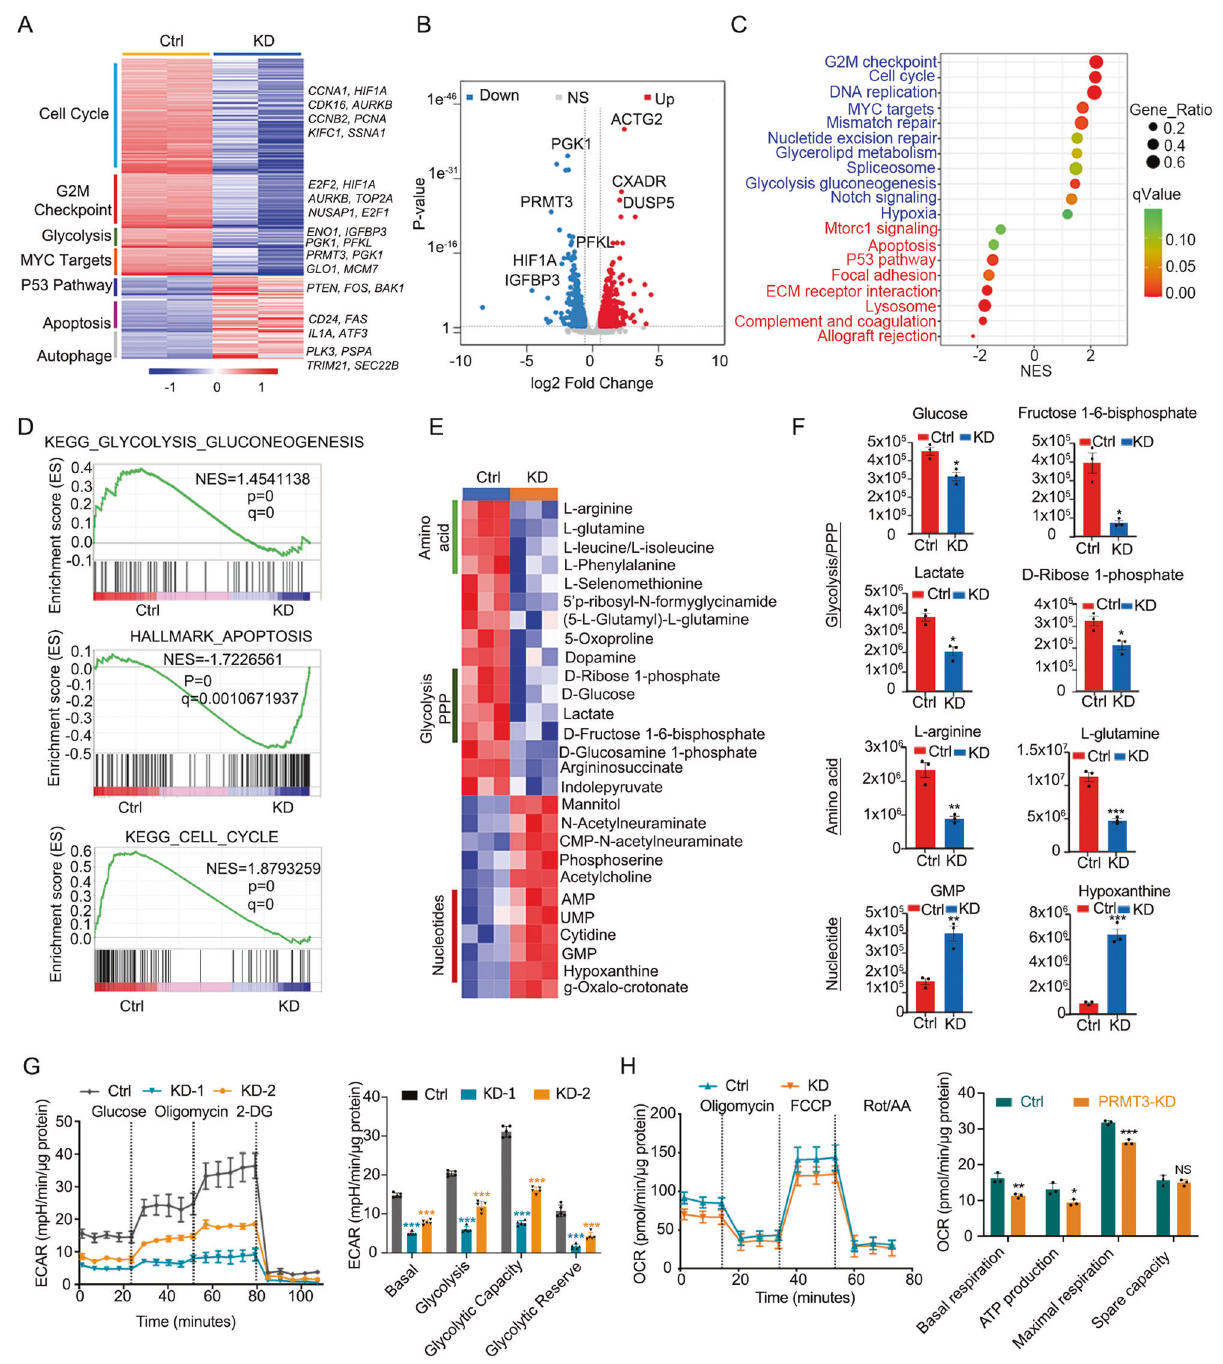
Fig. 6 PRMT3 de fi ciency decreases GBM progression by inhibiting aerobic glycolysis. A Heatmap of the genes differentially expressed in control and PRMT3-KD U251cells after 72 hr. B Volcano plot of transcriptome pro fi les of wild-type and PRMT3-KD U251cells. Red and blue dots represent genes signi fi cantly upregulated or downregulated, respectively in PRMT3-KD cells compared to wild-type cells (fold change >1.5, p < 0.05). C KEGG analysis of the upregulated and downregulated genes in PRMT3-KD compared with wild-type U251cells. D GSEA enrichment plots of the glycolysis pathway, apoptosis and cell cycle pathway showing the comparison of gene expression pro fi les in wild-type U251cells and PRMT3-KD cells. NES, normalized enrichment score; p value, represents the statistical signi fi cance of the enrichment score. E Heatmap of the metabolites changed in PRMT3-KD GSC20 cells. F Relative levels of the metabolites in glycolysis/PPP, amino acid and nucleotide metabolism in Ctrl (red) and PRMT3-KD (blue) GSC20 cells. Data are presented as means ± SEM; n = 3 independent experiments; * p < 0.05; ** p < 0.01; *** p < 0.001; two-tailed unpaired Student t-test. G ECAR was measured with a Seahorse XF96 Flux analyzer (left) and quanti fi cation (right) in Ctrl and PRMT3-KD GSC20 cells. * p < 0.05, ** p < 0.01, *** p < 0.001. one-way ANOVA with multiple comparison test. H . OCR was measured with a Seahorse XF96 Flux analyzer (left) and quanti fi cation (right) in Ctrl and PRMT3-KD GSC20 cells. * p < 0.05, ** p < 0.01, *** p < 0.001. two-tailed unpaired Student t-test. N.S., not signi fi cant.